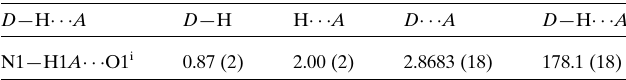
Table 2 Hydrogen-bond geometry (A˚ , (cid:3) ) for form